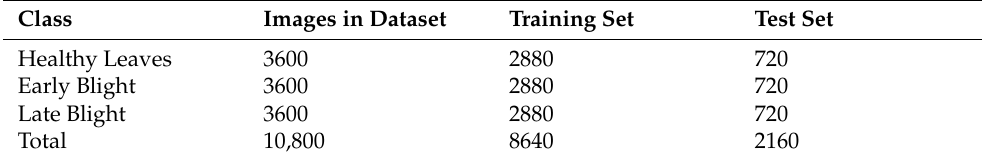
Table 3. List of categories included in the PlantVillage dataset after data augmentation.